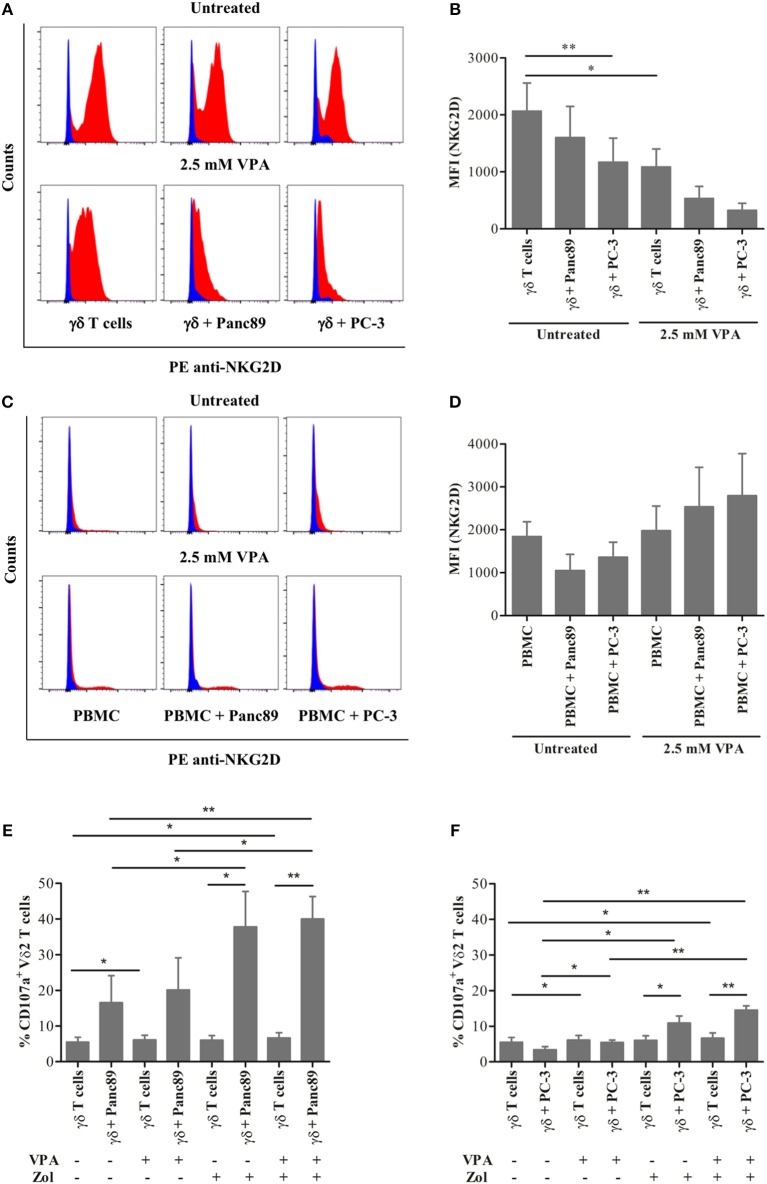
Effect of the HDAC inhibitor VPA on NKG2D receptor expression on effector cells. γδ T cells from 12 days zoledronic acid-stimulated PBMC (A–B) or freshly-isolated PBMC (C–D) were co-cultured with Panc89 and PC-3 cells at a 1:1 ratio in the presence or absence of 2.5 mM VPA, as described in Supplementary Figure 1. After 24 h of co-culture, γδ T cells (A–B) or PBMC (C–D) were collected by gentle pipetting and analyzed for NKG2D receptor expression by flow cytometry. In the representative histograms (A,C), the upper panel represents the untreated effector cells or co-culture with Panc89 or PC-3 cells, and the lower panel represents additional 2.5 mM VPA treatment. Blue histograms represent isotype controls, while red histograms represent anti-human PE-NKG2D staining. A summary of three to four independent experiments as bar plots is represented by Median Fluorescence Intensity (MFI) in (B,D). MFI was calculated by subtracting MFI of isotype controls from MFI of test antibodies. Mean values ± S.E. of median fluorescence intensity (MFI) in the bar plot are shown in comparison to untreated solo γδ T cells with statistically significant p-value < 0.01 or 0.05 as ** or *, respectively. In a similar set-up, γδ T cells were analyzed for the expression of CD107a (degranulation marker) after 24 h co-culture with (E) Panc89 and (F) PC-3 in the presence or absence of VPA and Zol (Zoledronate). The data represented here is the mean values ± S.E. of CD107a+ Vδ2 T cells from three independent experiments. The statistical significance is shown by ** or * for p-value < 0.01 or 0.05, respectively. Vδ2 T cells or lymphocyte-gated PBMC were acquired after respective staining. The results were further analyzed using FlowJo software.